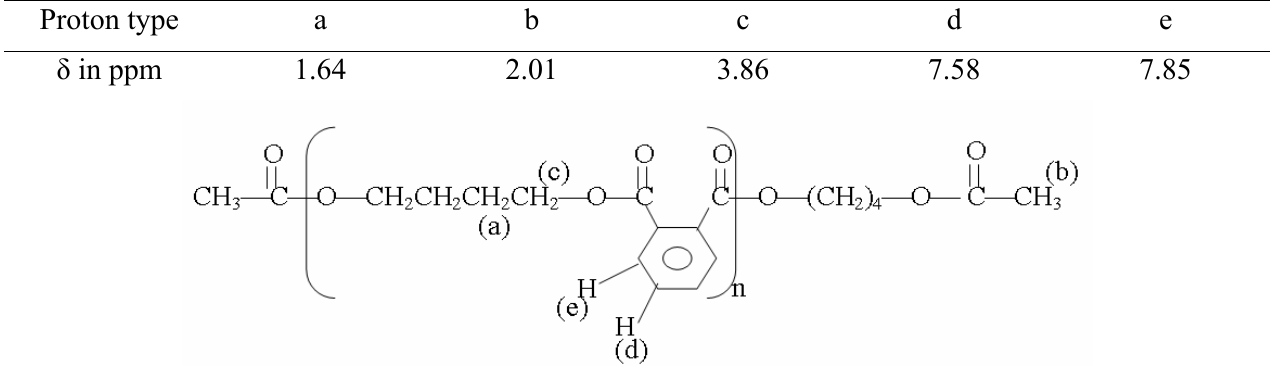
Table 6. Results of products analysis by 1 H NMR spectroscopy